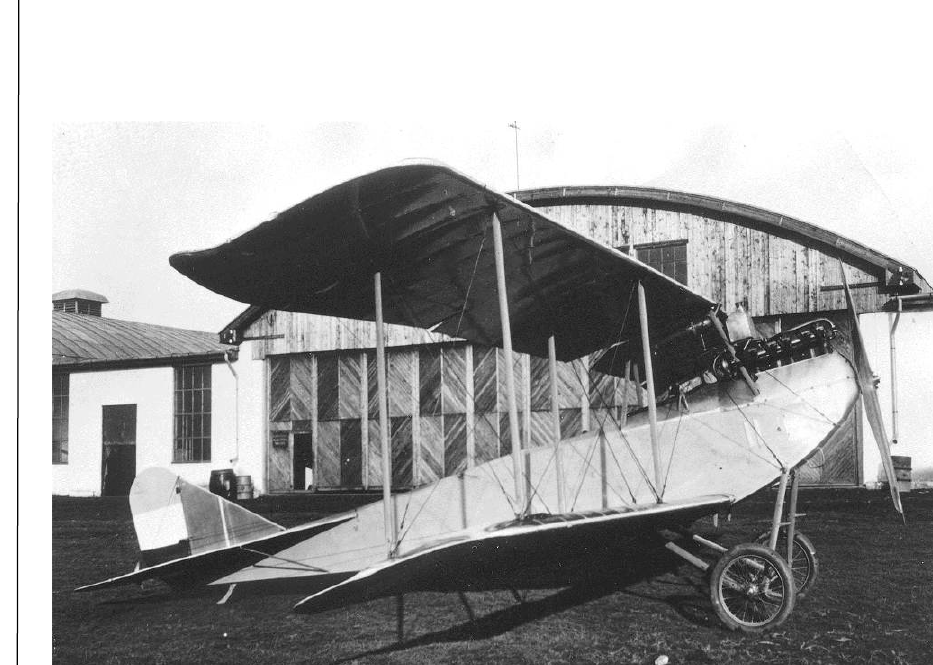
Figure 1 – Ikarus – Rogožarski-small Brandenburg, collection Ognjan Petrovi ć Рисунок 1 – Икарус – Рогожарский малый Бранденбург , коллекция Огнян Петрович Слика 1 – Икарус – „ Рогожарски мали Бранденбург ” ( колекција Огњан Петровић